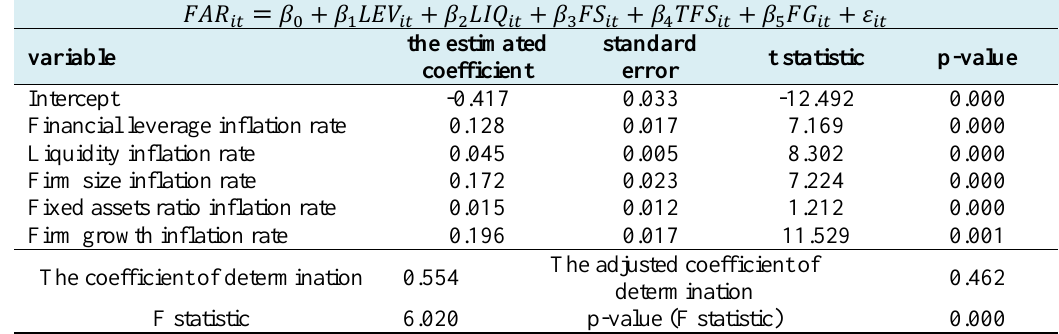
Table 21. The results of estimating the second model of research in the TSE (considering the effects of the inflation